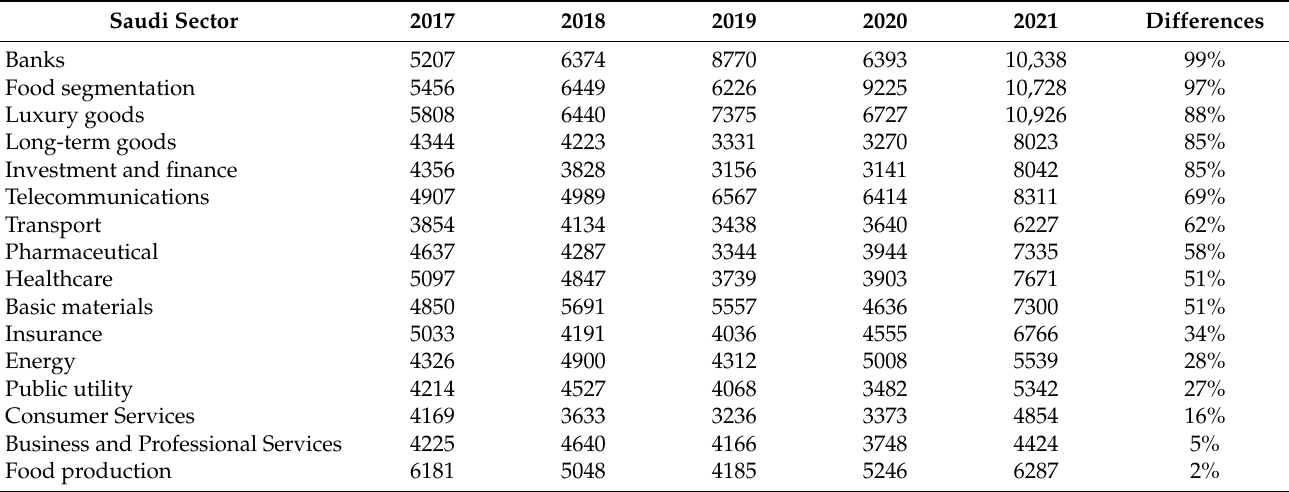
Table 2. TASI sectors’ indicators between 2017 and